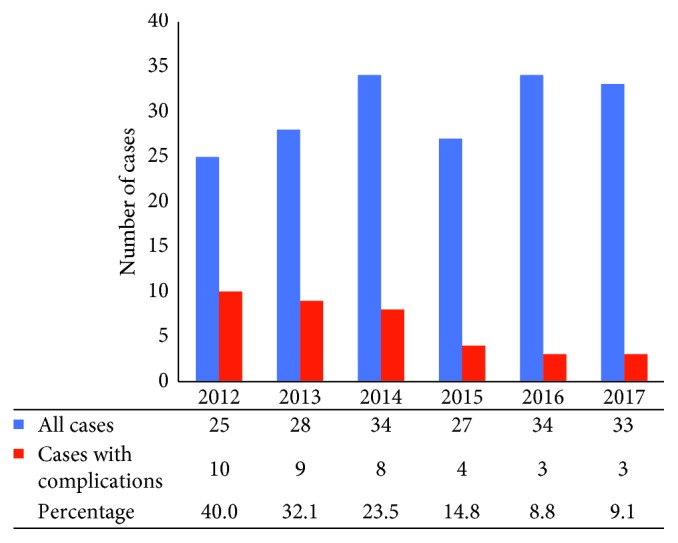
Cumulative experience reduces the rate of complications following DBS surgery. The graph shows relatively constant annual caseload but remarkable reduction in the percentage of cases with complications throughout the years.